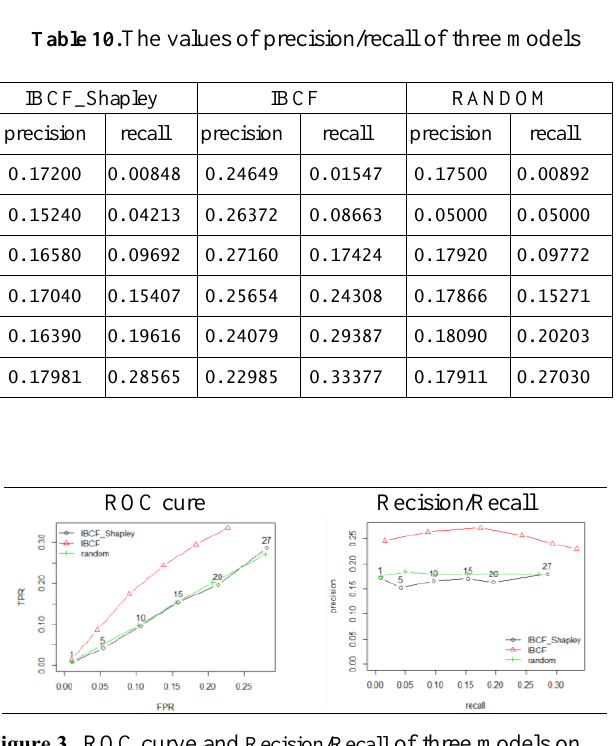
Figure 3. ROC curve and Recision/Recall of three models on Jester5k